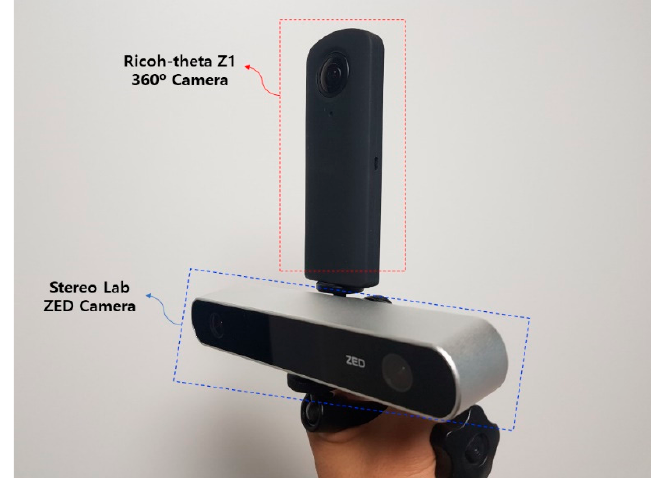
Figure 4. 360 ◦ camera and stereo-vision ZED camera. Figure 4. 360° camera and stereo-vision ZED camera. Figure 4. 360° camera and stereo-vision ZED camera.